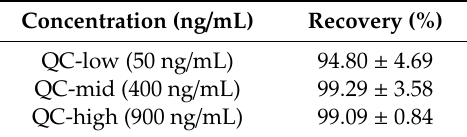
Table 3. Recovery (%) of sesamol in methanol and cell lysate ( n = 8). QC: quality